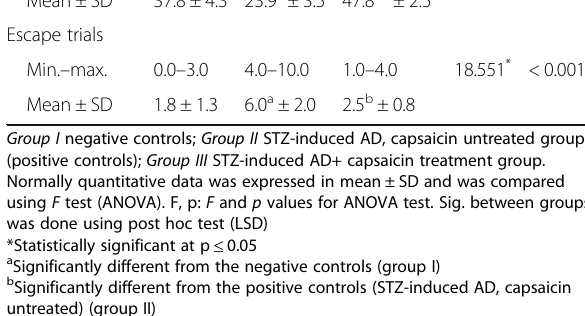
Table 4 Correlation between A β 1-42 (pg/g tissue) and the time spent (%) and the distance swum in target quadrant (%) and the retention latency (seconds) in the total samples (groups I, II,